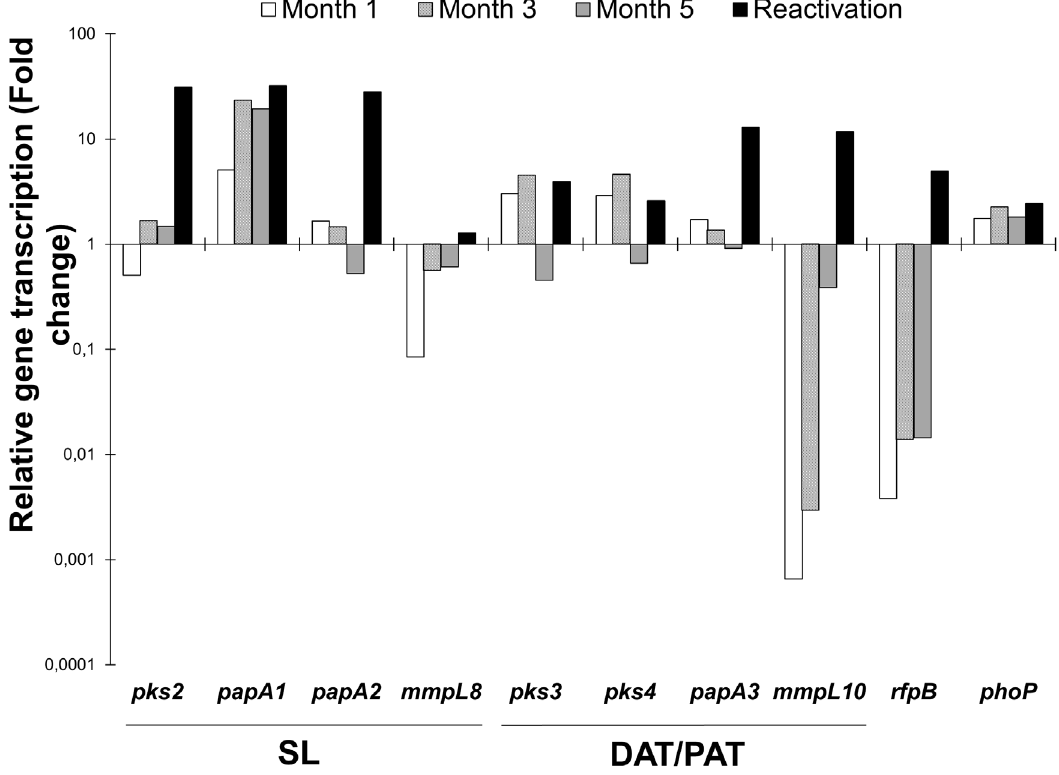
Figure 4. Invivo transcription of genes in M.tuberculosis H37Rv during long-lasting TB infection in mice. The relative quantification is expressed as the ratio of infection at months 1, 3, 5 and reactivation/transcription at day 28 of progressive infection TB. The presented data have statistically significant differences compared to transcription values at day 28 of progressive infection TB ( P , 0.05).